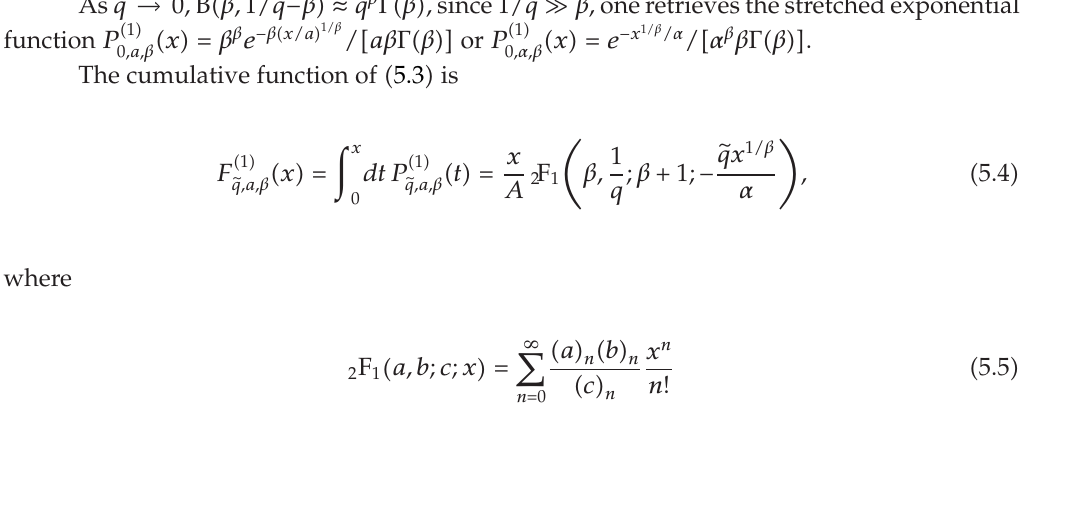
(cid:2) x (cid:3) (cid:7) e − x 1 /β /α / (cid:4) α β β Γ(cid:2) β (cid:3)(cid:5) 0 ,α,β